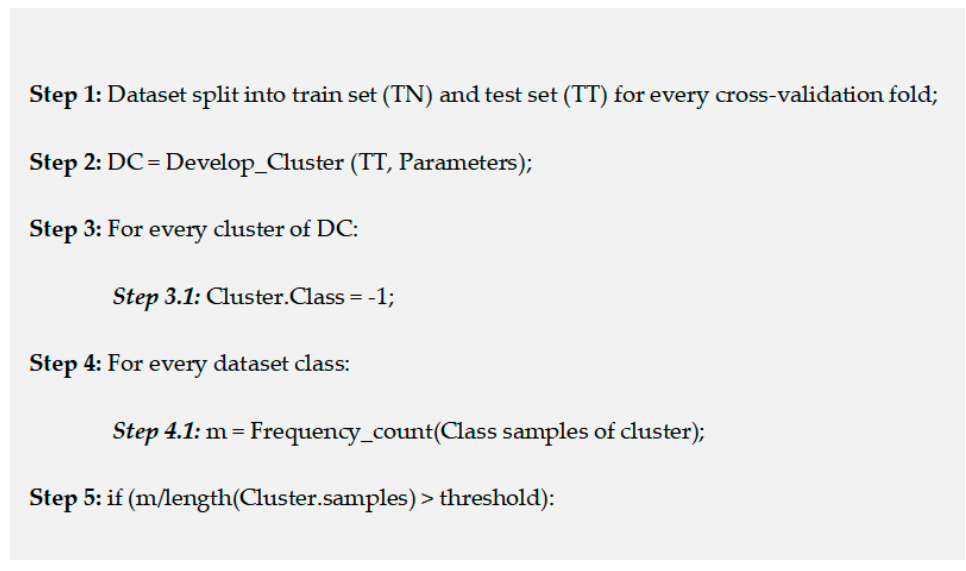
Figure 15. Pseudo code for Clustering process in Improved decision tree model.